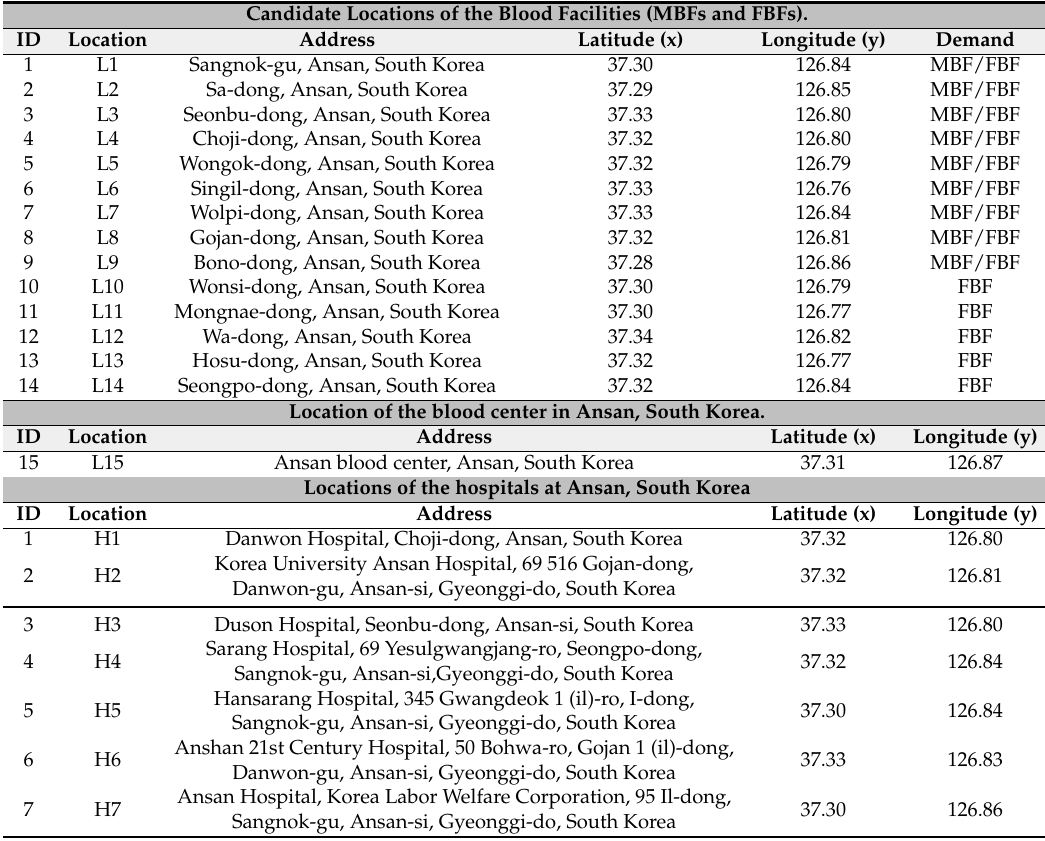
Table 3. Candidate locations of blood facilities and the fixed locations of the blood center and hospitals in Ansan, South Korea. Candidate Locations of the Blood Facilities (MBFs and